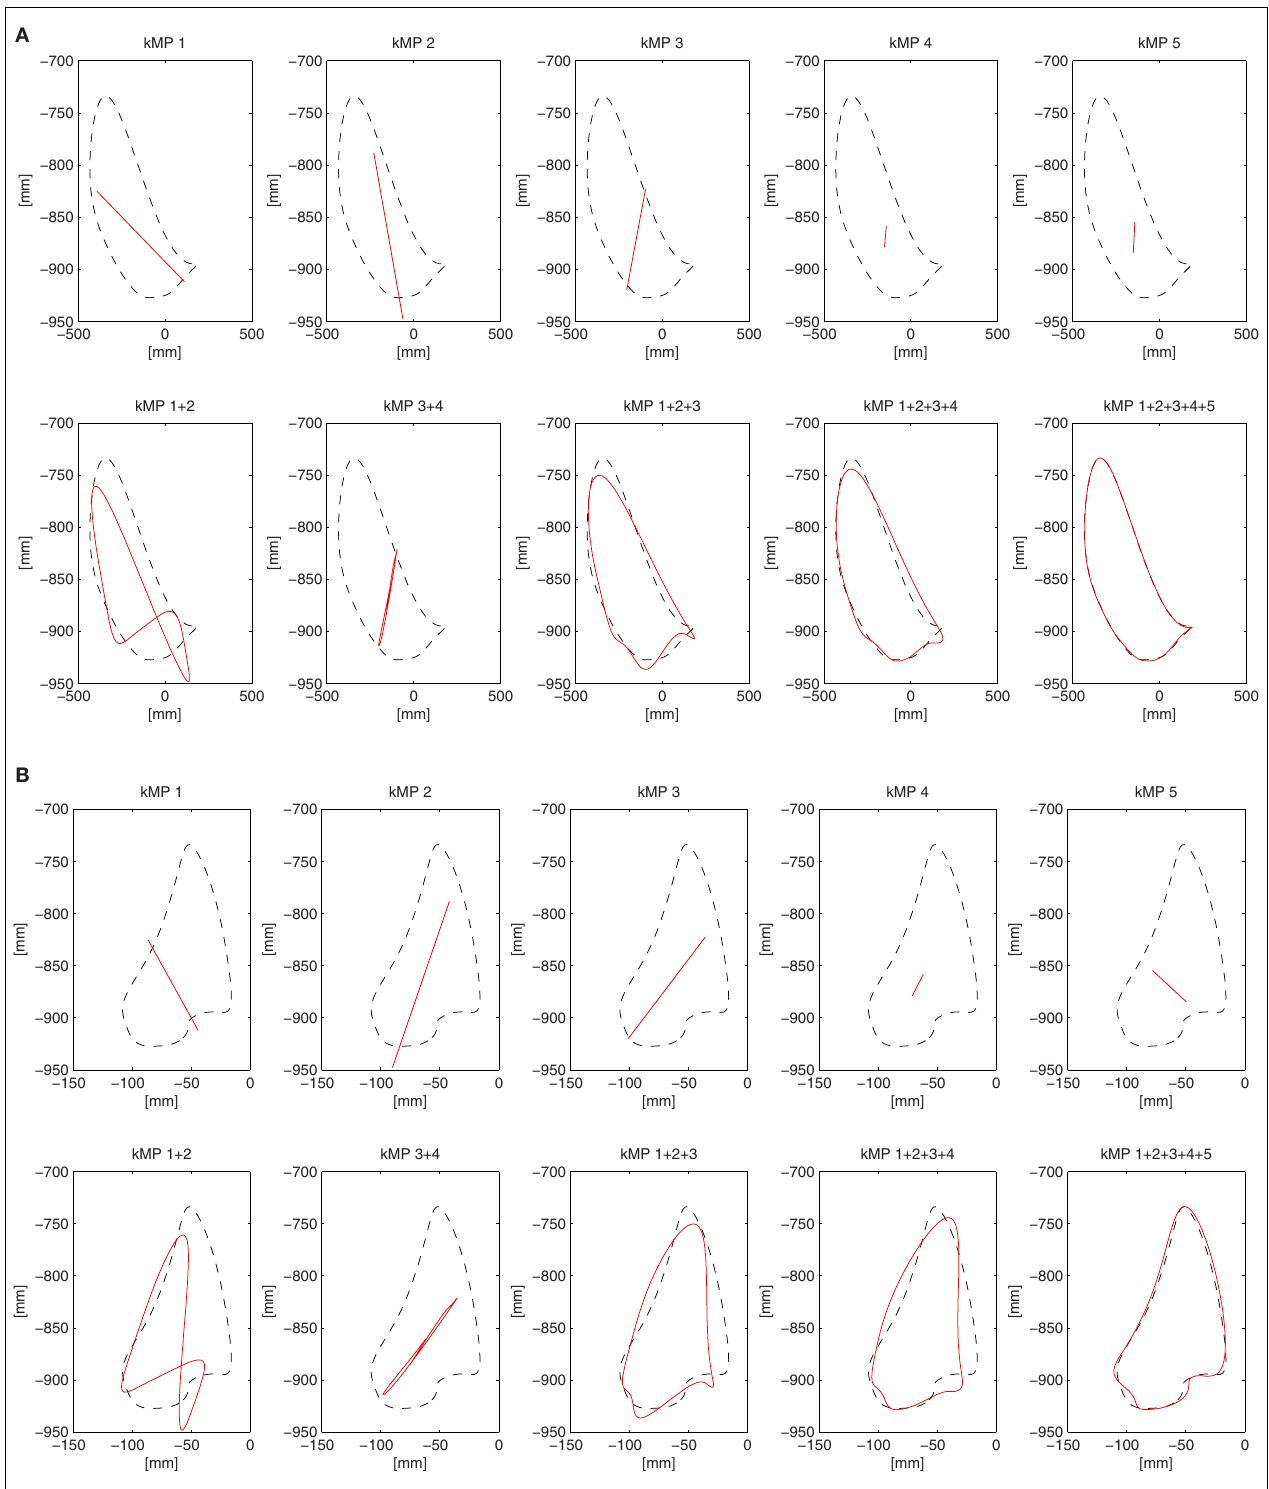
FIGURE 8 | Partial reconstruction from kMPs of the right foot trajectory (A) projected on the sagittal plane, and (B) projected on the coronal